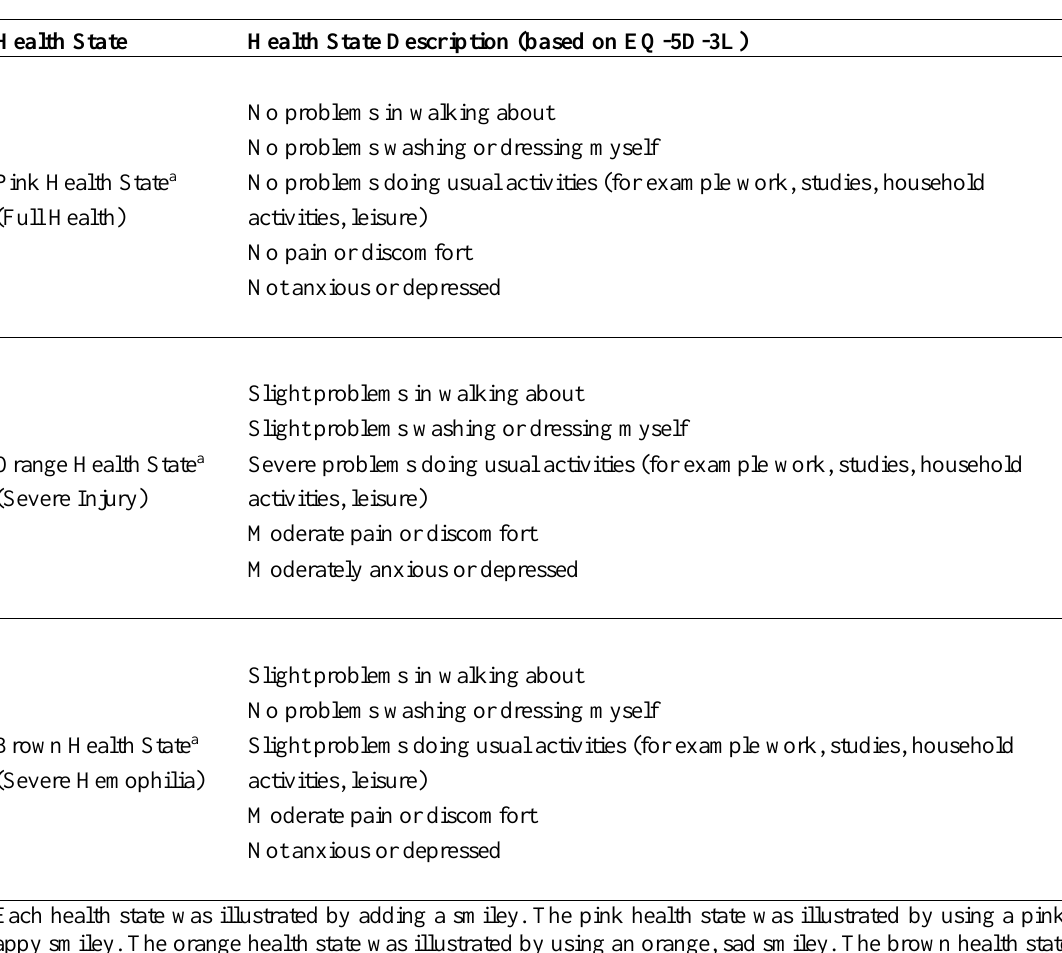
Health state descriptions used in the questionnaire